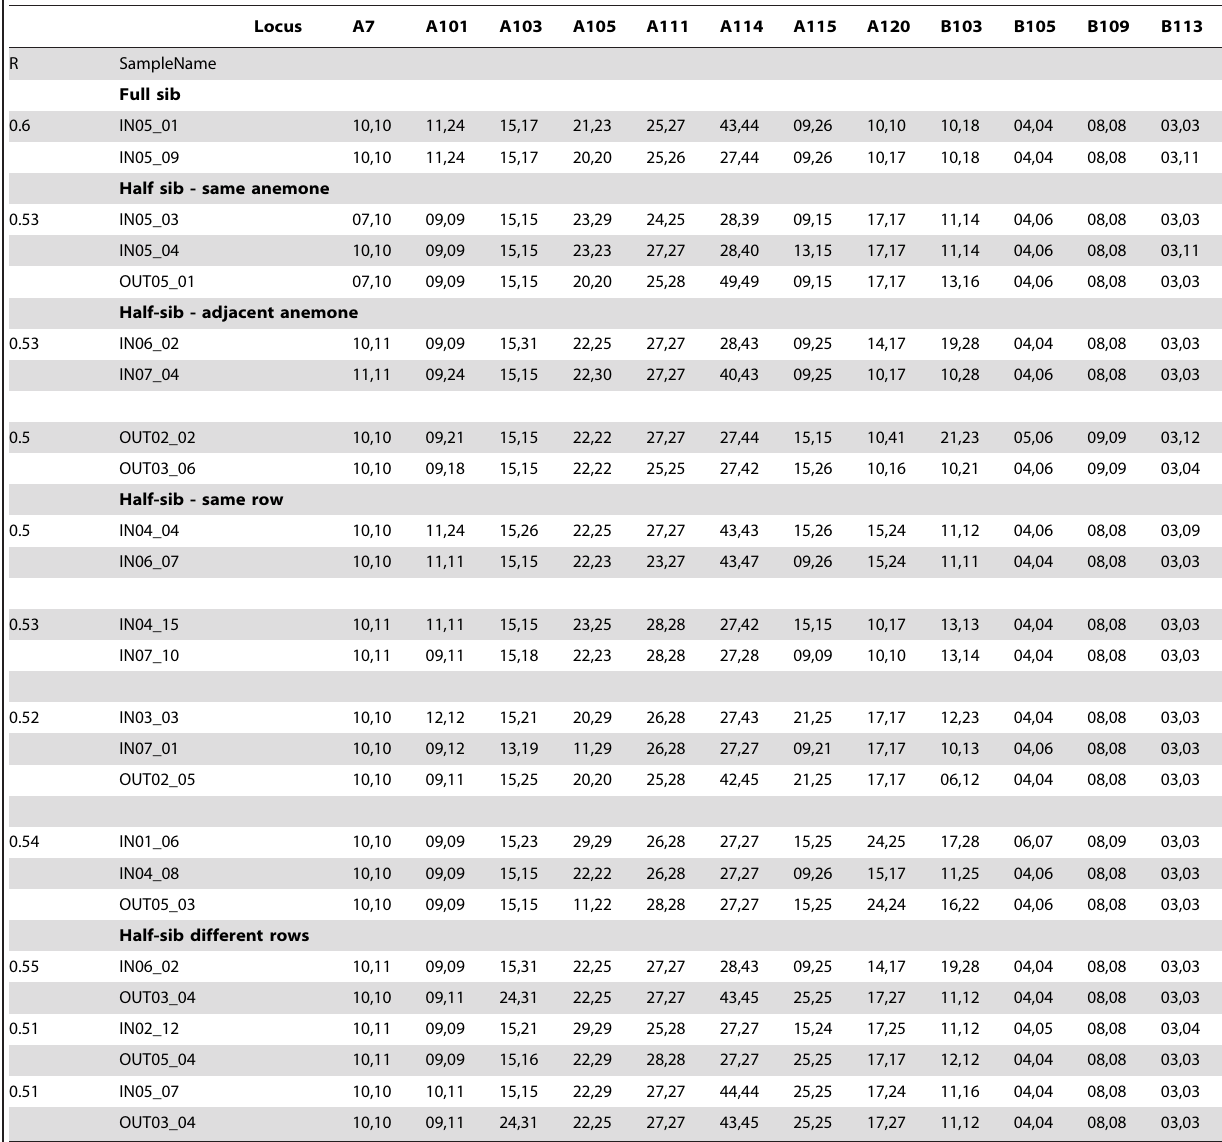
Table 2. Dascyllus trimaculatus siblings.